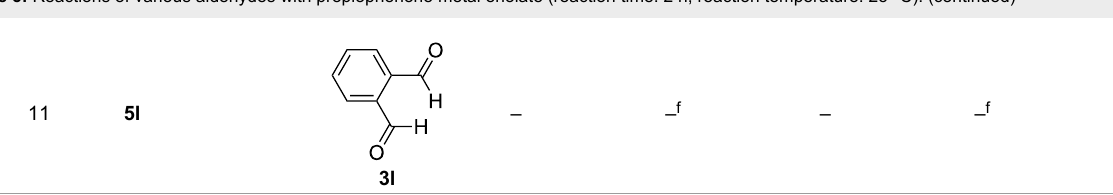
Table 5: Reactions of various aldehydes with propiophenone metal enolate (reaction time: 2 h, reaction temperature: 25 °C).